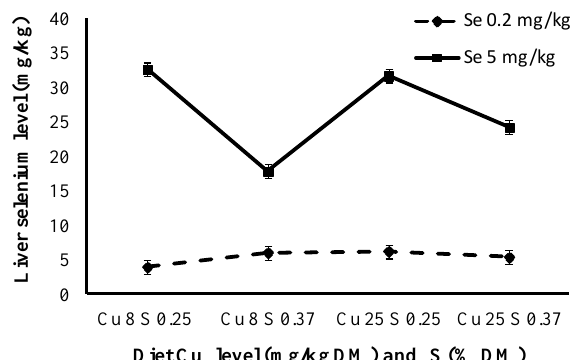
Figure 3. Liver selenium concentration of lambs with different levels of copper and sulphur in diet.